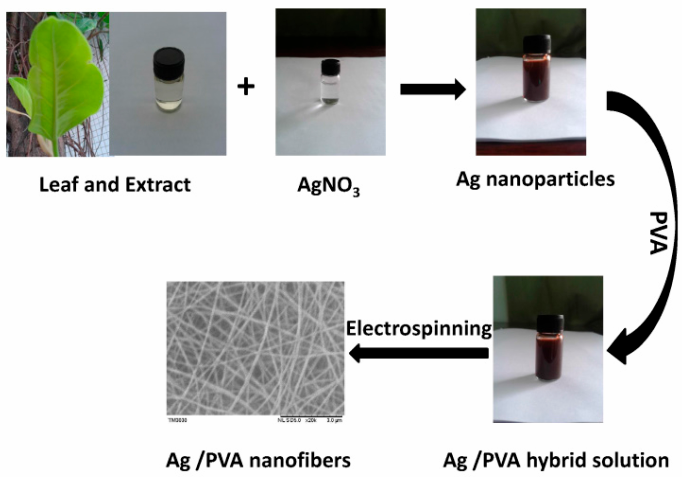
Figure 1. Schematic diagram of process for preparing Ag nanoparticles/PVA (polyvinyl alcohol) nanofibers.